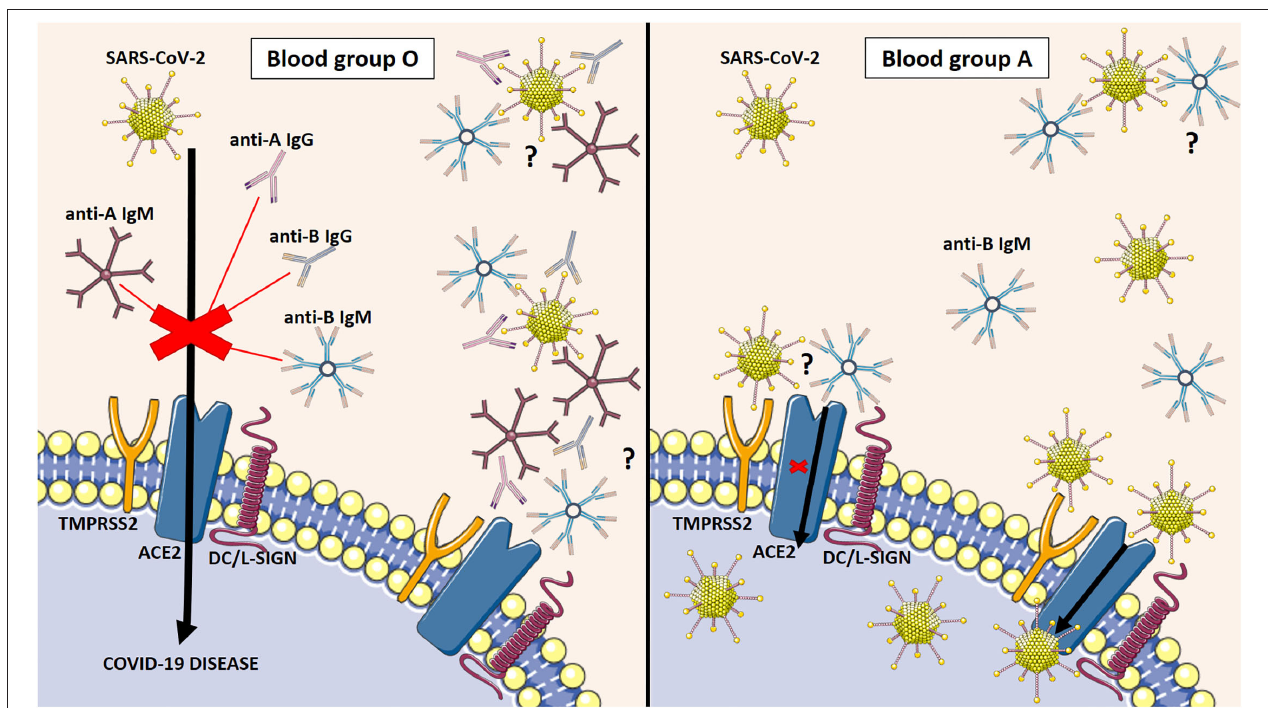
FIGURE 1 | Molecular mechanism that explains the susceptibility and severity of COVID-19 disease depending on the ABO blood group. The presence of anti-A antibodies and probably anti-B antibodies inhibit the interaction between the S protein of the virus and the ACE2 on the cell surface in the O blood group (Left side). The absence of antibodies in the A blood group facilitates the entrance of SARS-CoV-2 into the host cell and the consequent viral infection (Right side). ACE2: angiotensin-converting enzyme 2. TMPRSS2: transmembrane protease serine subfamily member DC/L-SIGN; dendritic-cell-specific ICAM3-grabbing nonintegrin.; Natural antibodies bind glycosylated or carbohydrate epitopes in the S protein of SARS-CoV-2 (on top) or ACE2